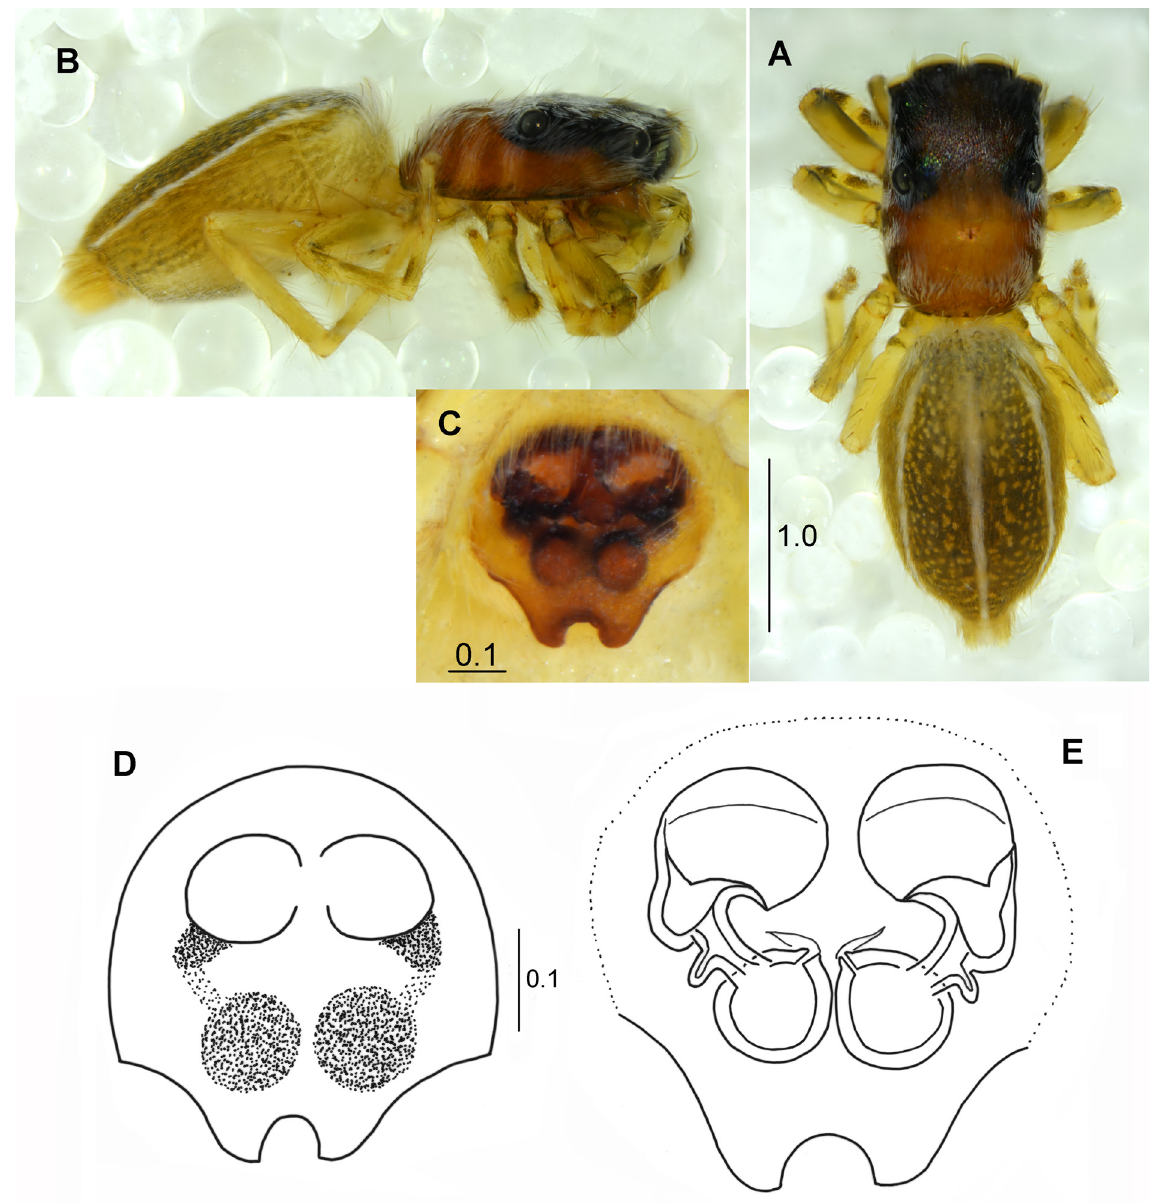
Fig. 34. Menemerus dubius Berland & Millot, 1941, lectotype, ♀ (MNHN). A . Habitus, dorsal view. B . Habitus, lateral view. C–D . Epigyne. E . Internal structure of